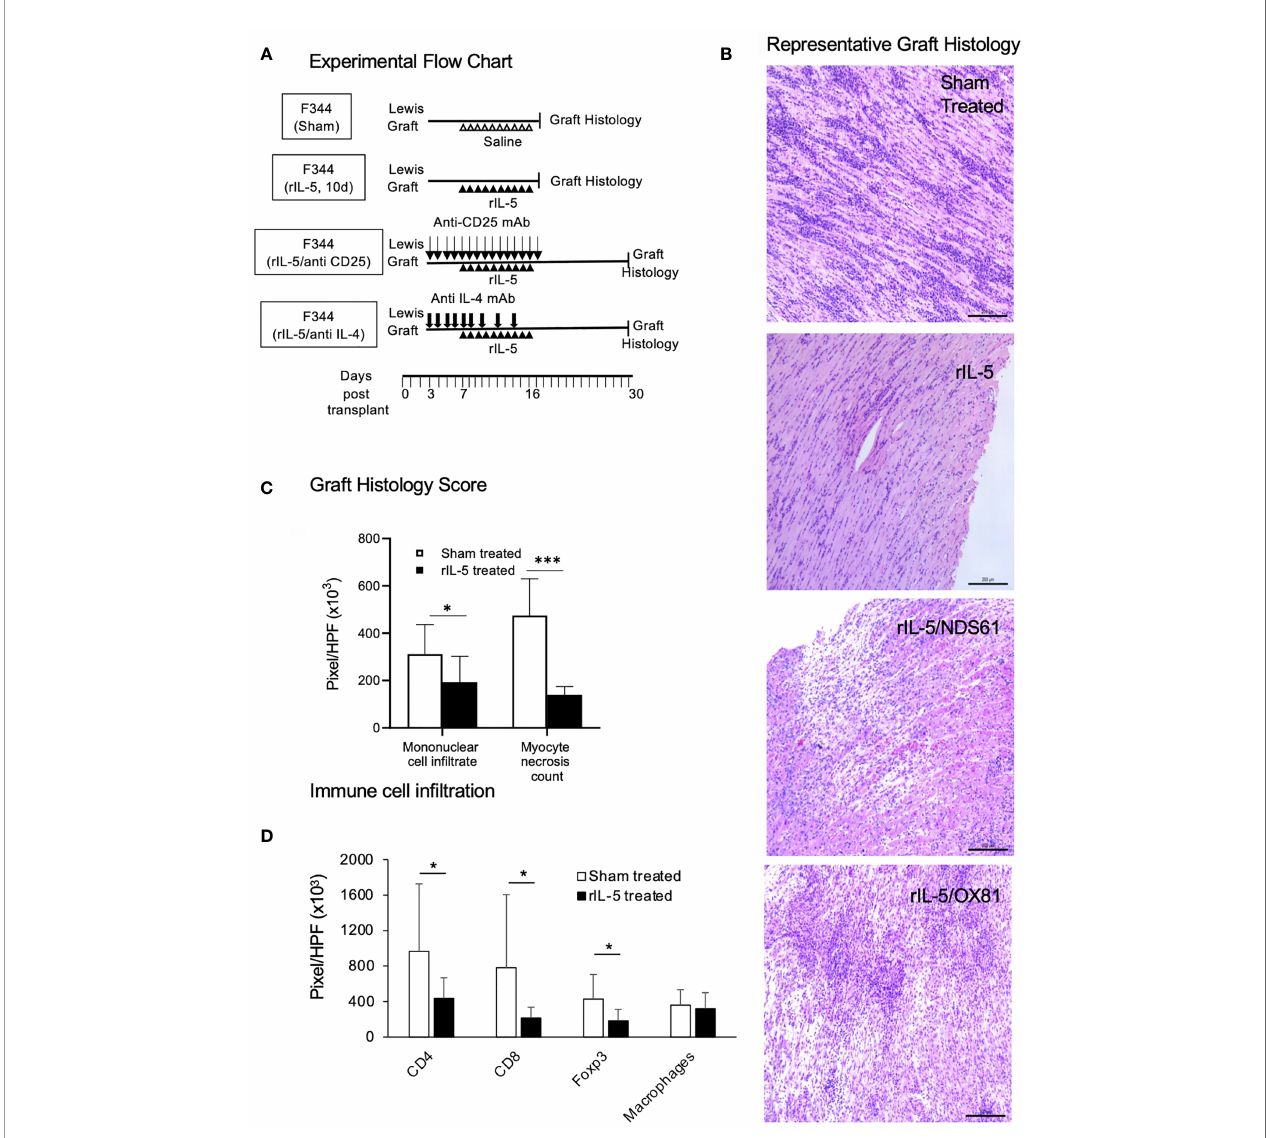
FIGURE 5 | rIL-5 treatment reduces myocyte necrosis and mononuclear cell in fi ltrates in Lewis heart grafts transplanted to F344 hosts. (A) Experimental Flow Chart. Representative animals from sham treatment and 10 day rIL-5 treatment ( Figure 3 ) groups were sacri fi ced for study of histology, myocyte damage, and mononuclear cell in fi ltrates in their cardiac allogafts. Some animals from anti-CD25 and anti-IL-4 mAb therapy together with rIL-5 treatment groups ( Figure 4 ) were sacri fi ced for histological studies. (B) Photomicrographs of H&E sections of Lewis cardiac allografts from F344 hosts, Samples were taken at days 17-19 post-transplant shortly after daily rIL-5 treatment had stopped. Images taken by a Leica DFC 450C camera with 400X magni fi cation on a Leica DM 2000 LED microscope. Heart grafts from sham- treated hosts had large areas of mononuclear cell in fi ltration and scattered in fi ltrate between myocytes (Top panel). There were wide areas of myocyte necrosis. Heart grafts from animals treated with rIL-5 had minimal mononuclear in fi ltration between myocytes and minimal myocyte necrosis (second panel). Grafts from hosts treated with rIL-5 that also received NDS61 an anti-CD25 mAb to deplete Treg (third panel) and MRCOX81 mAb to block IL-4 (bottom panel) had large areas of myocyte necrosis and cell in fi ltration. (C) Areas of mononuclear cell in fi ltrate and myocyte necrosis was assessed as pixels per high power fi eld (HPF) in multiple images taken at 400 X magni fi cation on a Zeiss Axioscope A1 microscope (Zeiss, North Ryde, Australia) using Image Pro Plus 6.2 software (Media Cybernetics, Rockville, MA). Data expressed as mean ± SD, *p < 0.05, ***p < 0.001. Area of mononuclear cell in fi ltration measured in pixels was signi fi cantly less in grafts in rIL-5 treated rats than those from sham treated rats; 193,883 ± 108,701 vs 311,4112 ± 124,968 (p = 0.03) ( Figure 3C ). Area of myocytes necrosis measured in pixels was signi fi cantly lower (p<0.00011) in heart grafts from rIL-5 treated rats than in hearts from sham treated controls ( Figure 3C ). (D) Immunostaining for mononuclear cells in heart grafts from F344 rats showing comparison of cell in fi ltrate in grafts from rIL-5 treated animals to those from sham treated. Grafts from rIL-5 treated animals had signi fi cantly reduced area of CD4 + cells (p<0.05), CD8 + cells (p<0.05), and Foxp3 + cells (p<0.05) compared to those from sham treated animals. The ratio of Foxp3 + cells in CD4 + cells was similar in rIL-5 treated and sham-treated rejection controls. There was no difference in in fi ltration of ED1 + macrophages. Photomicrographs of these stained sections are in Supplementary Figure 2